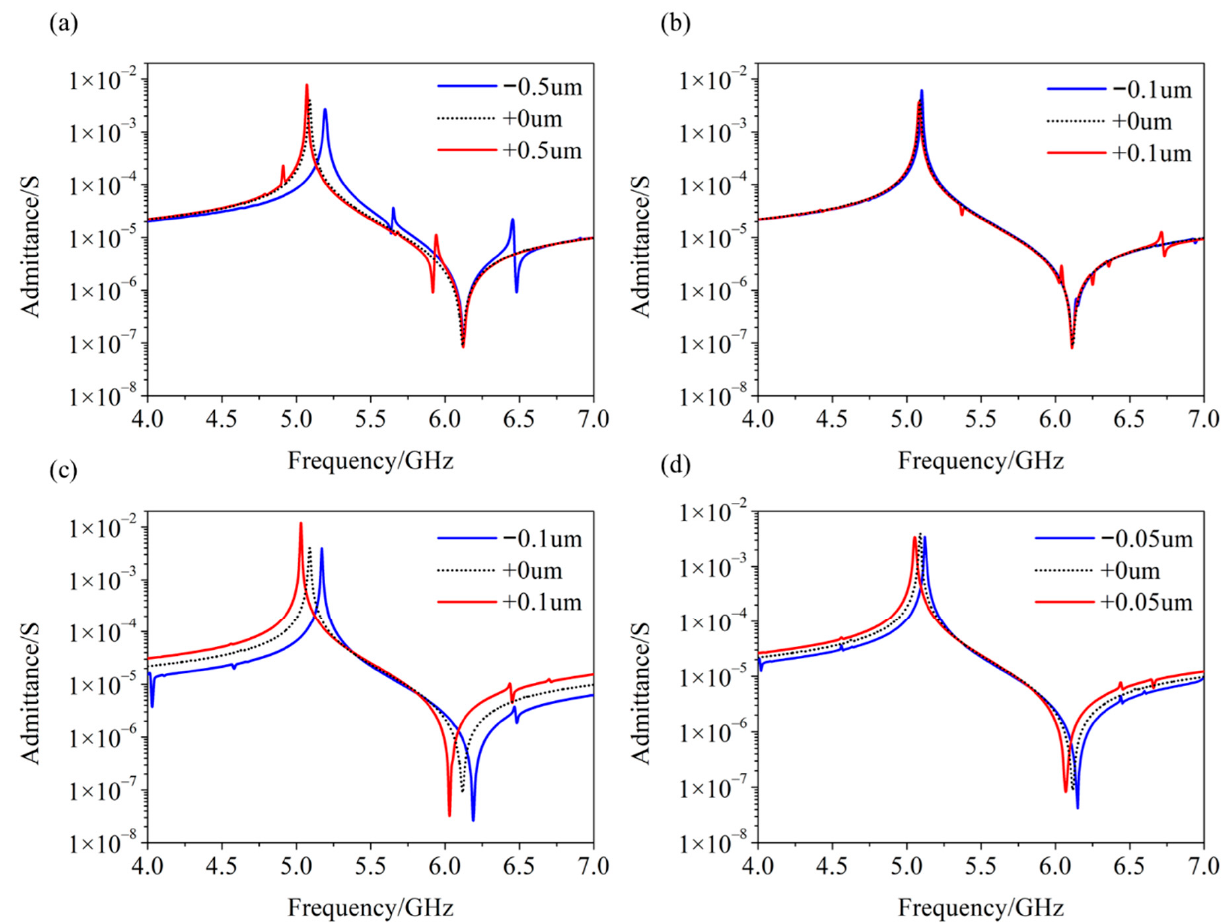
Figure 6. Calculated admittance of the SM-YABR depending on different period ( p ) and electrode-width (Le) of the interdigital transducers (IDTs). ( a ) p = 2 ± 0.5 μ m, Le = 500 nm; ( b ) p = 2 ± 0.1 μ m, Le = 500 nm; ( c ) p = 2 μ m, Le = 500 ± 100 nm; ( d ) p = 2 μ m, Le = 500 ± 50 nm.